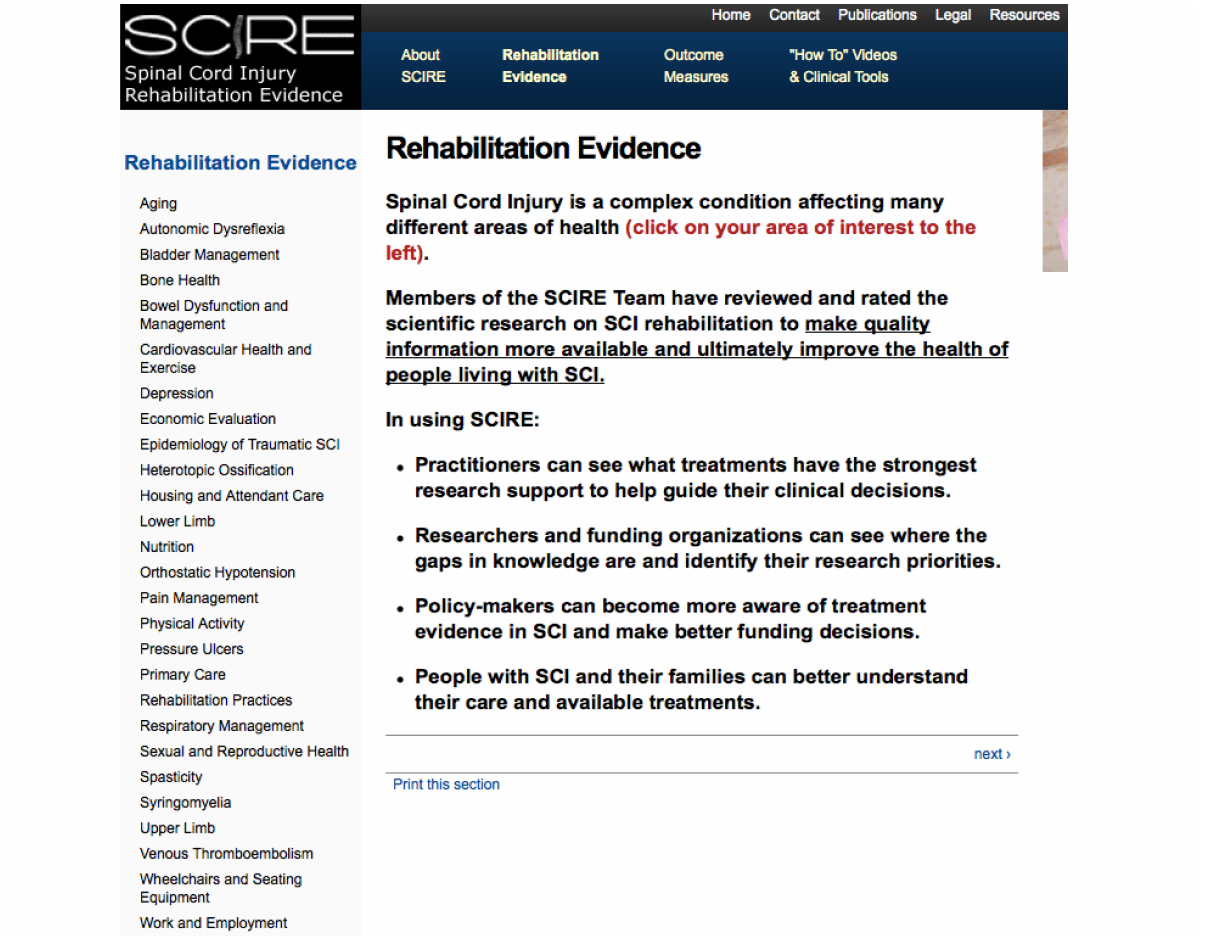
Figure 1. Screenshot illustrating the 27 sections providing rehabilitation evidence related to spinal cord injury. Each section includes background information on the topic, tables of relevant individual studies, a discussion synthesizing the data, a summary of the levels of evidence, and a summary of key